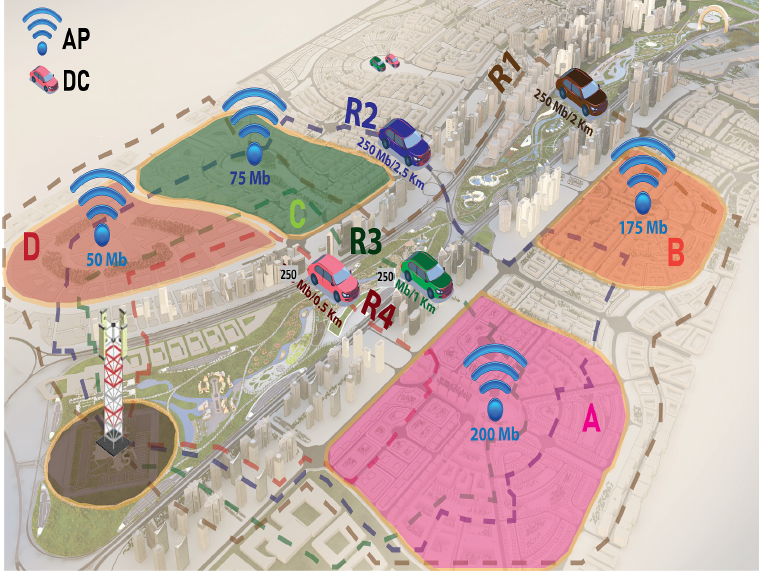
Figure 6. Example